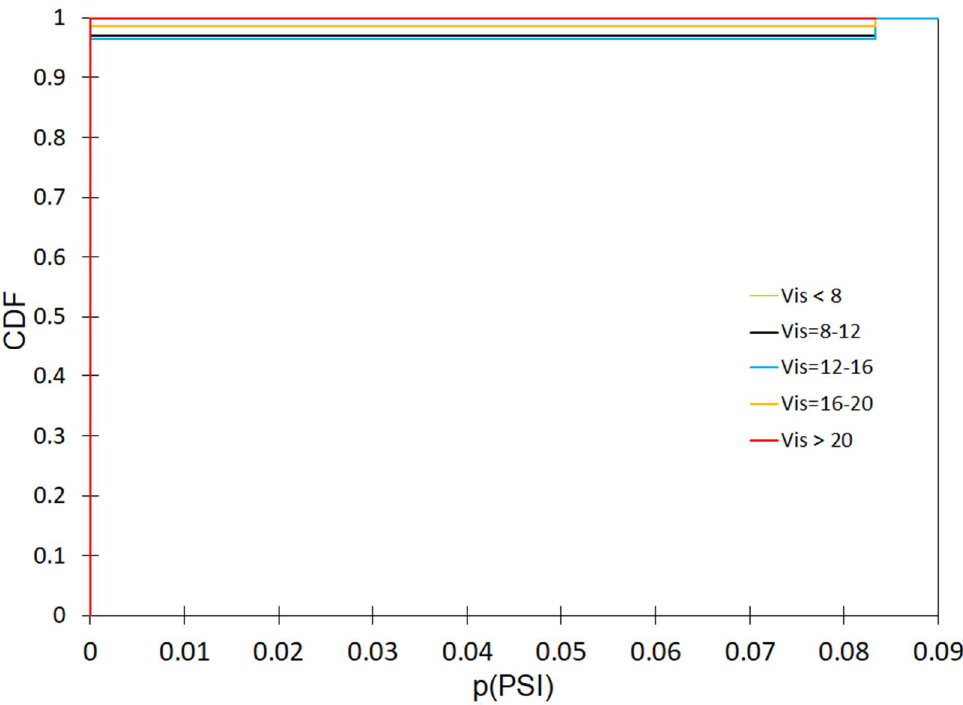
Figure A38. Effect of visibility on the incidence of high spring mortality for rainy days.